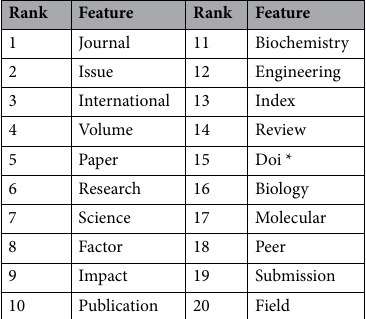
Table 2. Top 20 feature words identified by the proposed academic journal predatory checking (AJPC) system. *Doi (digital object identifier) is a term designating an intellectual copyright for a name or idea posted on the